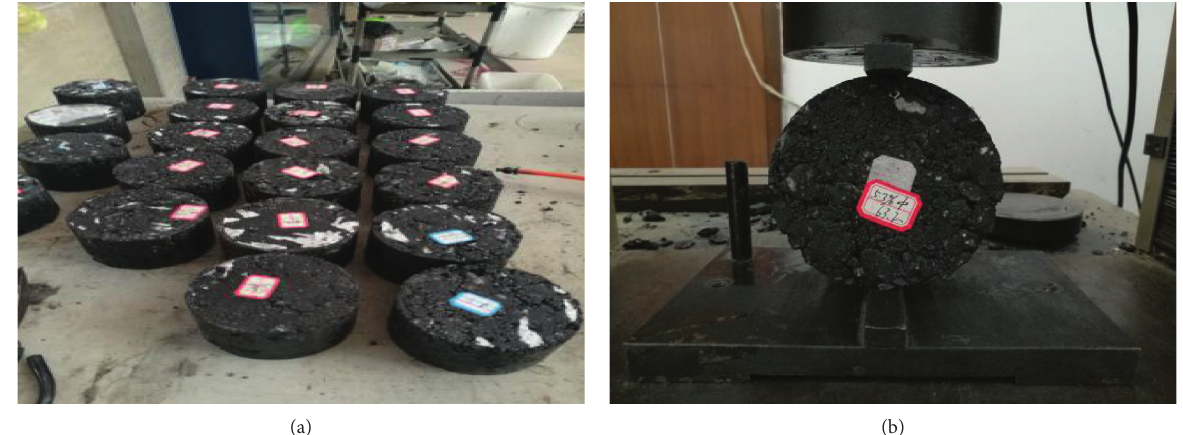
Figure 2: Freeze-thaw splitting test. (a) Small Marshall specimens. (b) Splitting test.